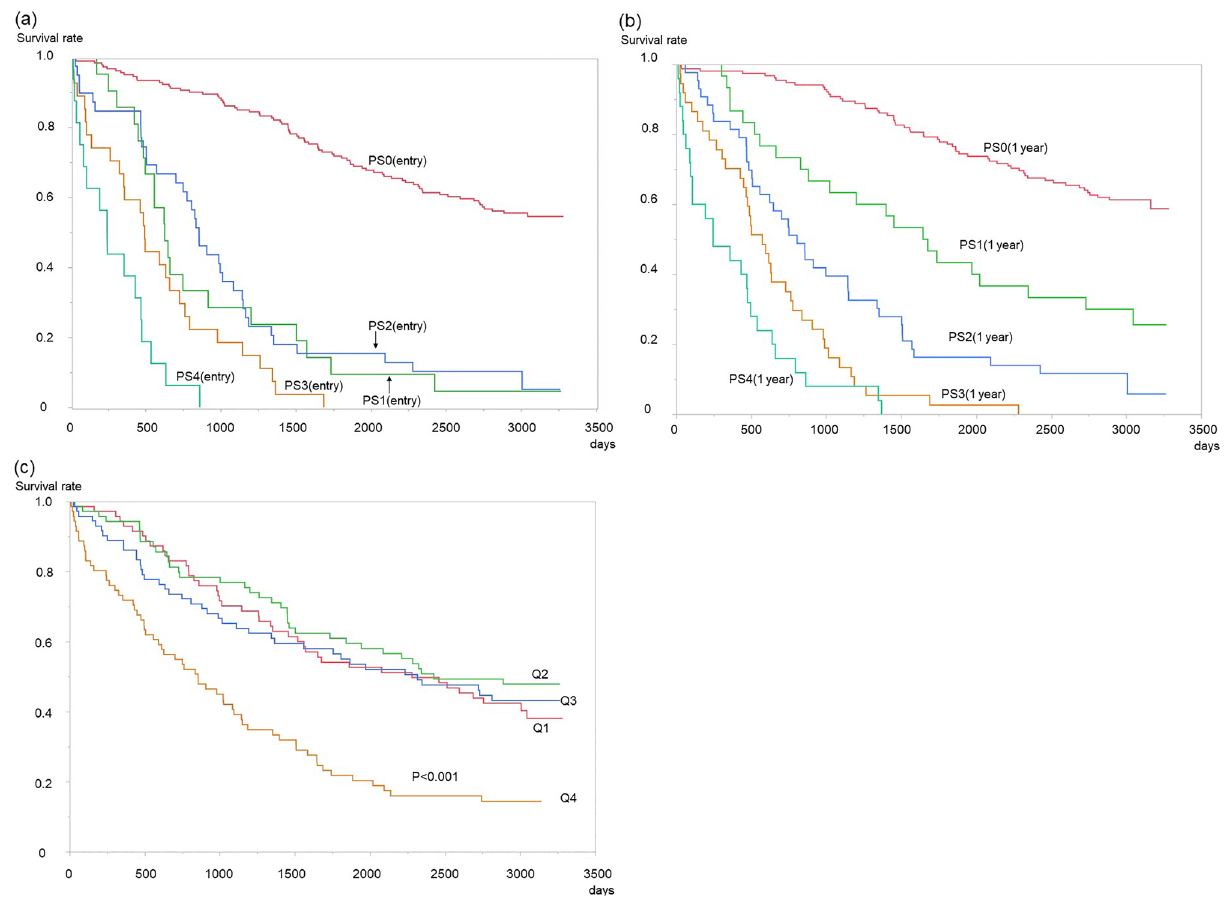
Figure 3. Kaplan–Meier analyses of participants. (a) Survival curve by the Eastern Cooperative Oncology Group Performance Status (ECOG-PS) at the entry. PS: Eastern Cooperative Oncology Group Performance Status. Apart from ECOG-PS 1 and PS 2, there were significant differences in each group (p < 0.001). (b) Survival curve by the ECOG-PS 1 year after entry. There were significant differences in each group (p < 0.001). (c) Survival curve by quartile of % change in the psoas muscle mass index (Q1–Q4). There was no significant difference among Q1–Q3; however, Q4 had a significantly worse outcome compared with Q1–Q3 (p < 0.001). Statistical analyses were performed using the JMP Pro 15.0.0